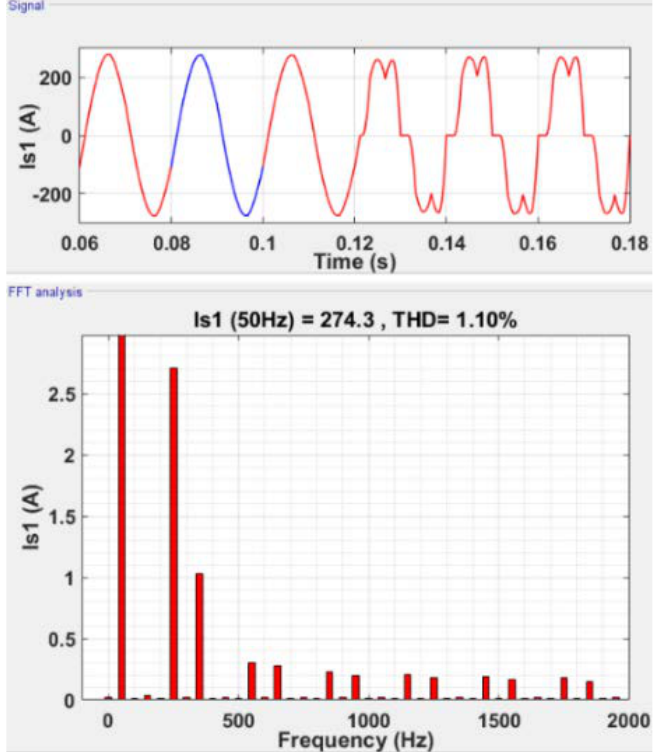
Figure 9. Current filtering using the twisting-controller.